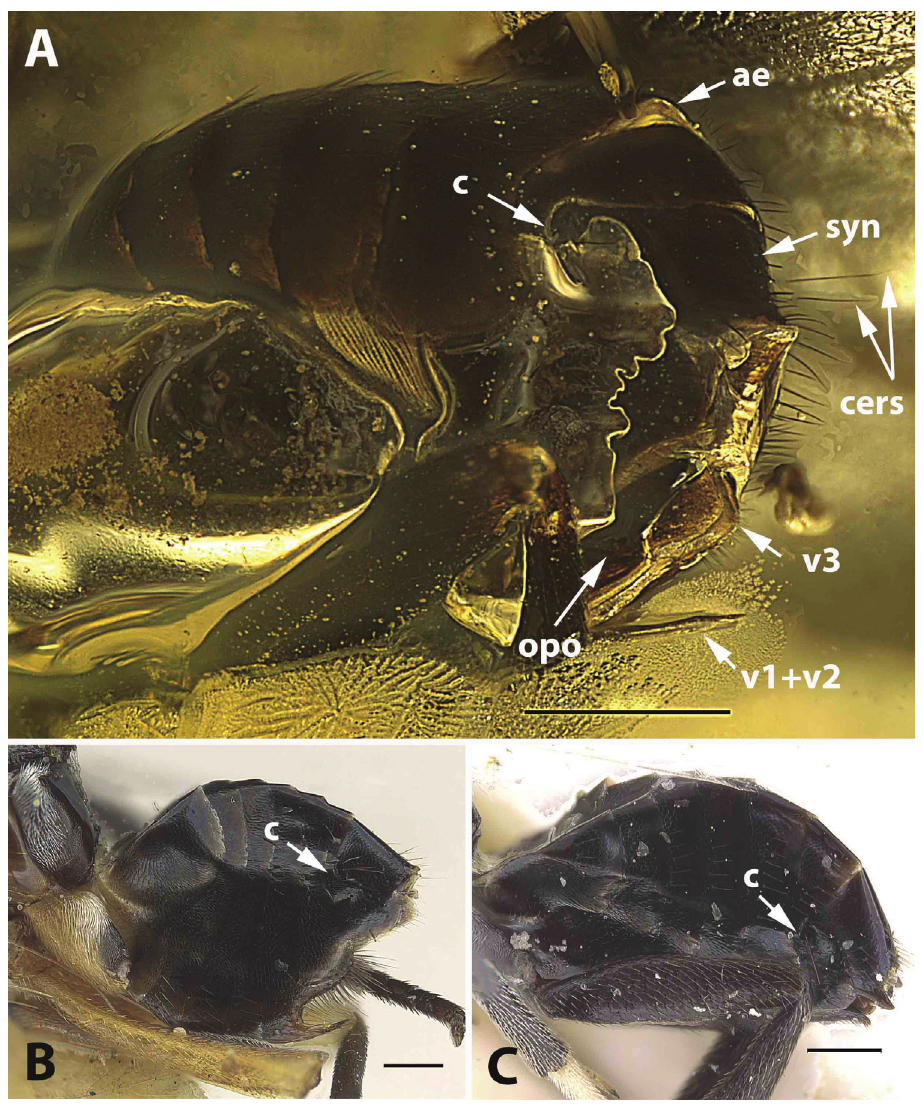
Figure 9. Metasoma, lateral A S. glaesaria , female, Rovno specimen B, C Prionomastix morio (Dalman, 1820) B female C male. (ae – arched elevation of Mt6, c – cercus, cers – cercal setae, syn – syntergum, v1+v2 – ovipositor stylet, v3 – ovipositor sheath). Scale bars: 0.2